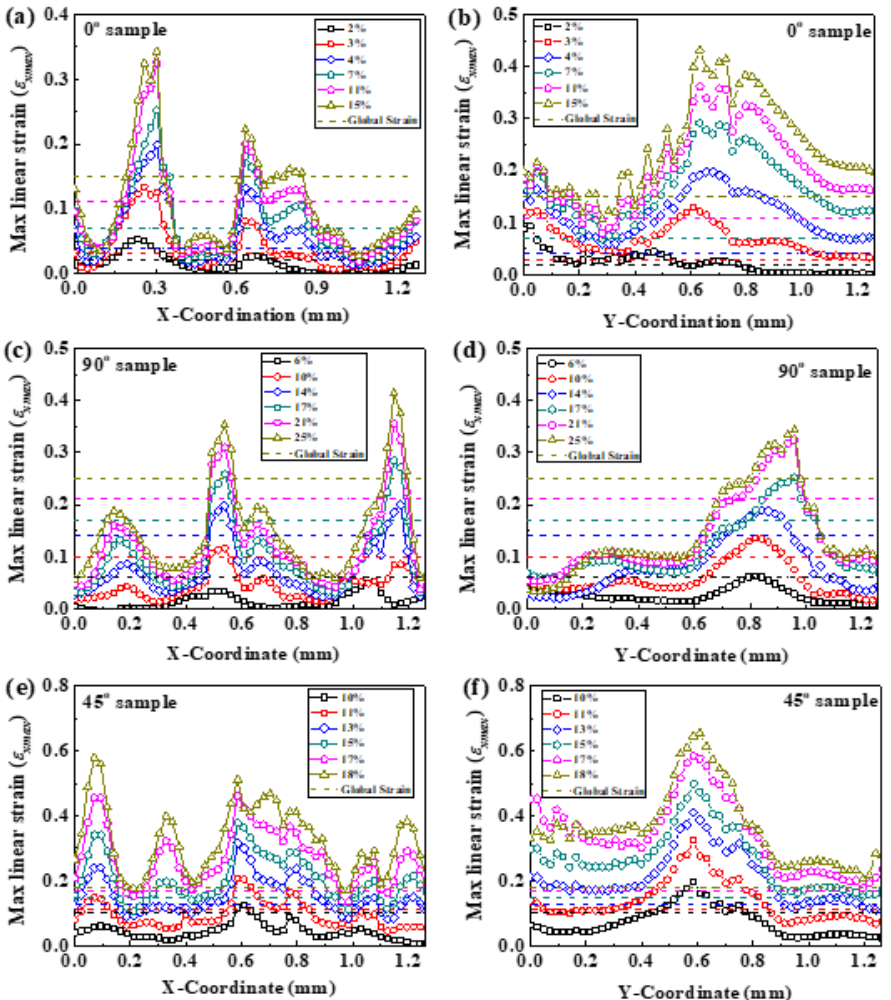
Figure 7. Profile of the distributions of the maximum ε xmax values at different global strains of ( a ) 0°, ( c ) 90°, and ( e ) 45° specimens on the maximum shear stress plane, i.e., along the dash lines ( x -axis), and at different global strains of ( b ) 0°, ( d ) 90°, and ( f ) 45° specimens along the dotted lines ( y -axis) in Figures 4–6.